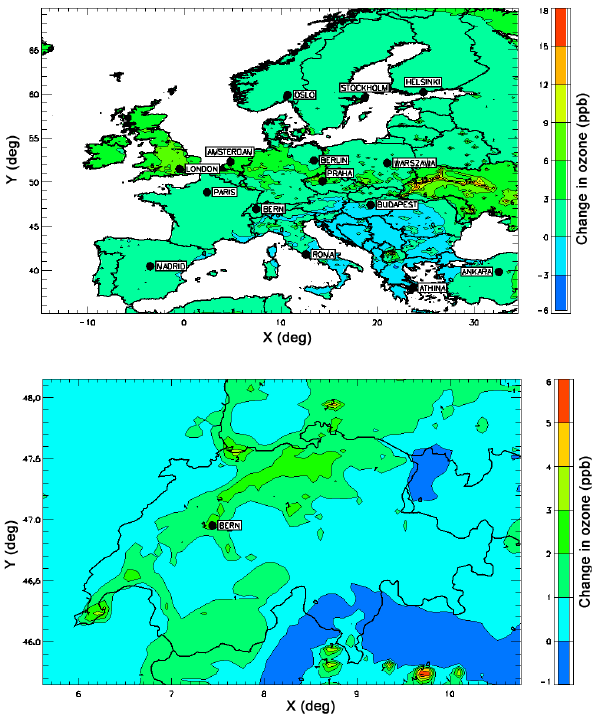
Figure 7. Changes (ppb) in annual average ozone mixing ratios over the European (upper panel) and Swiss (lower panel) domains,